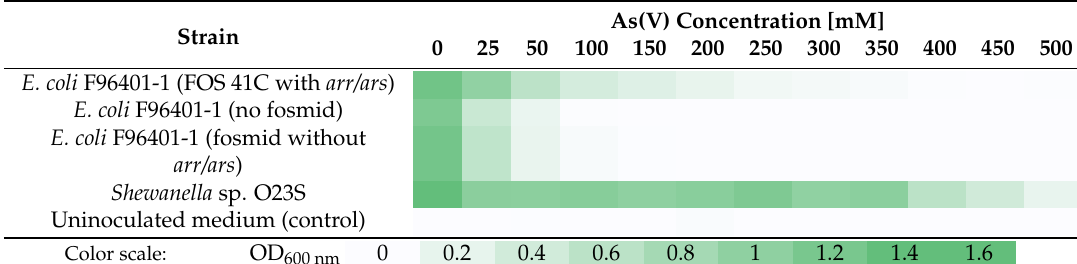
Table 3. Growth of strains with and without the arr/ars module on LB medium supplemented with As(V) under aerobic conditions. Heatmaps reflect the intensity of